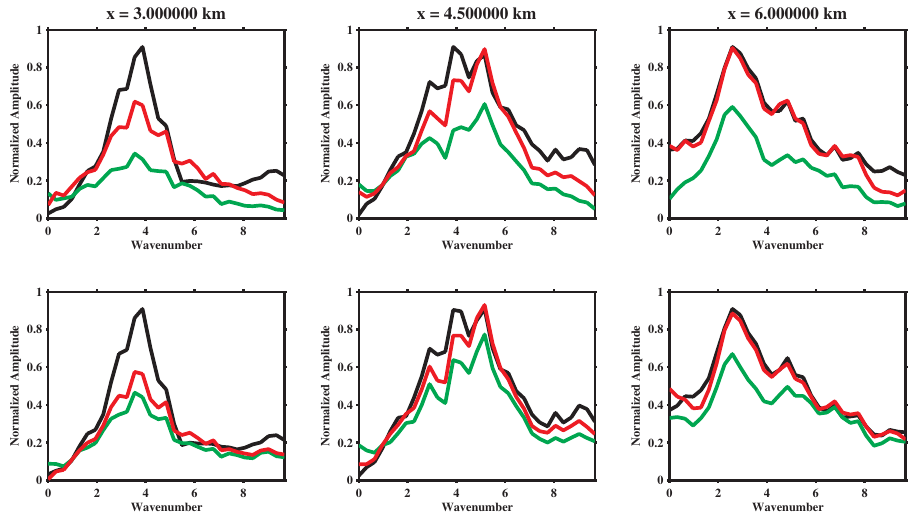
Figure 15. The 1D wavenumber spectrum of vertical profiles, corresponding to Figure 14. Black lines denote the true model, red lines indicate the AEC-EFWI results, and green lines are the EFWI